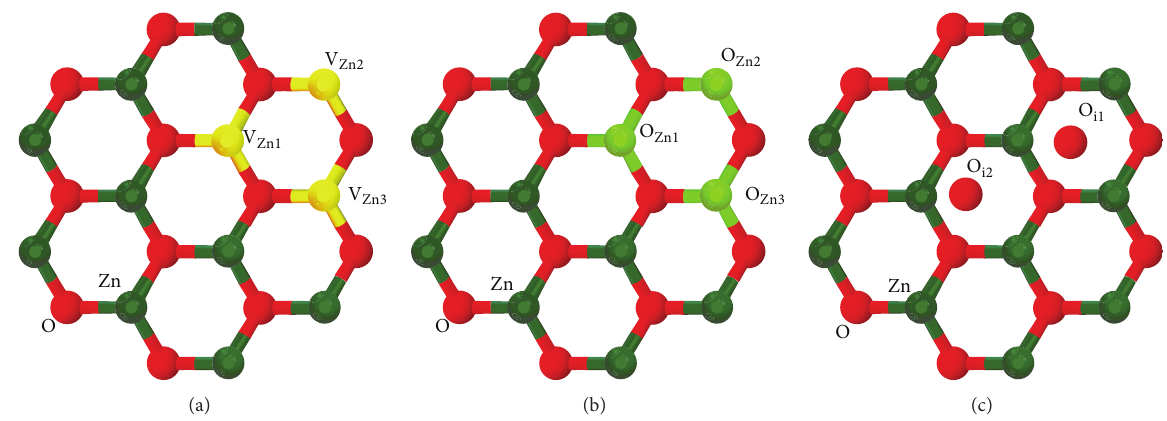
Figure 5: The structure of ZnO nanorods (a) with V Zn , (b) with O i , and (c) with O Zn defect.